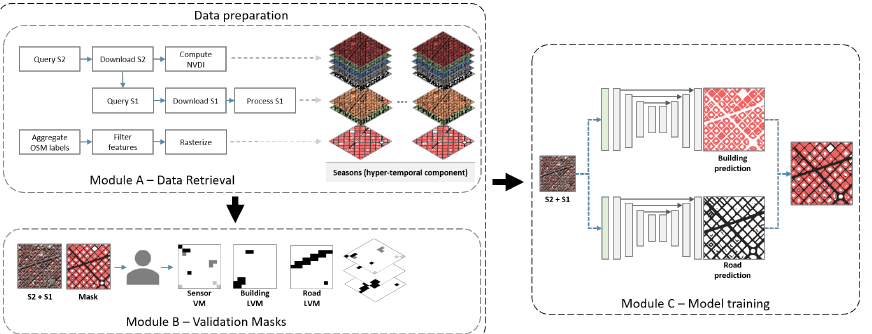
Figure 1. Overview of the proposal. Module A shows how the data is retrieved and pre-processed. Module B outlines the data-set validation phase. It must be noted that in Module B, Building LVM and Road LVM stands for the Label-specific Validation Masks corresponding for the building and road labels, respectively. Finally, Module C depicts the inference procedure and how the generated mappings could be